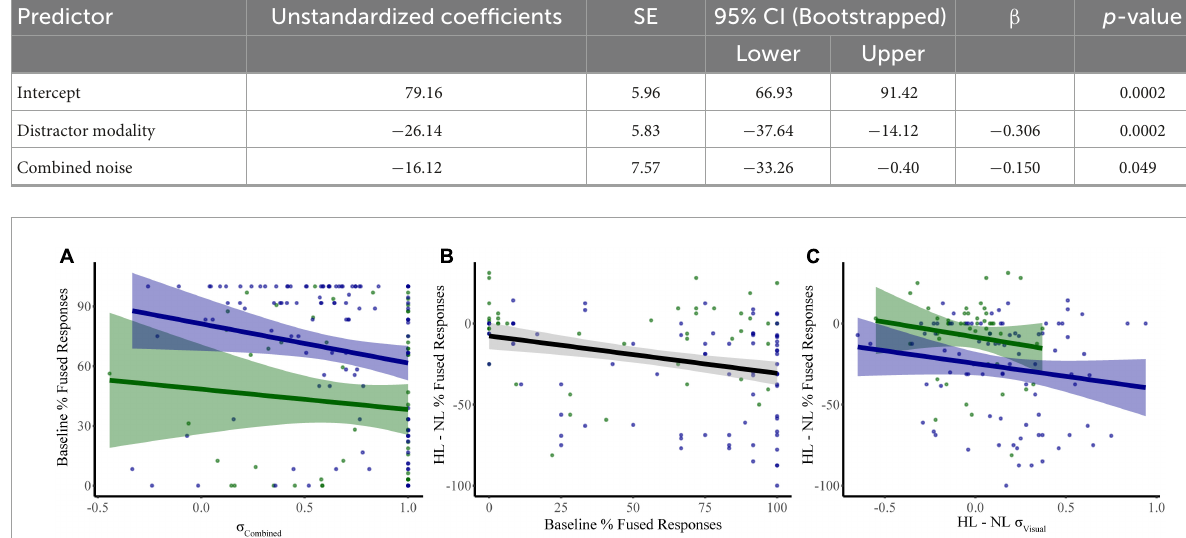
TABLE 1 Multiple linear regression: Baseline McGurk reports showing predictive power of distractor modality and combined noise on baseline McGurk perception.